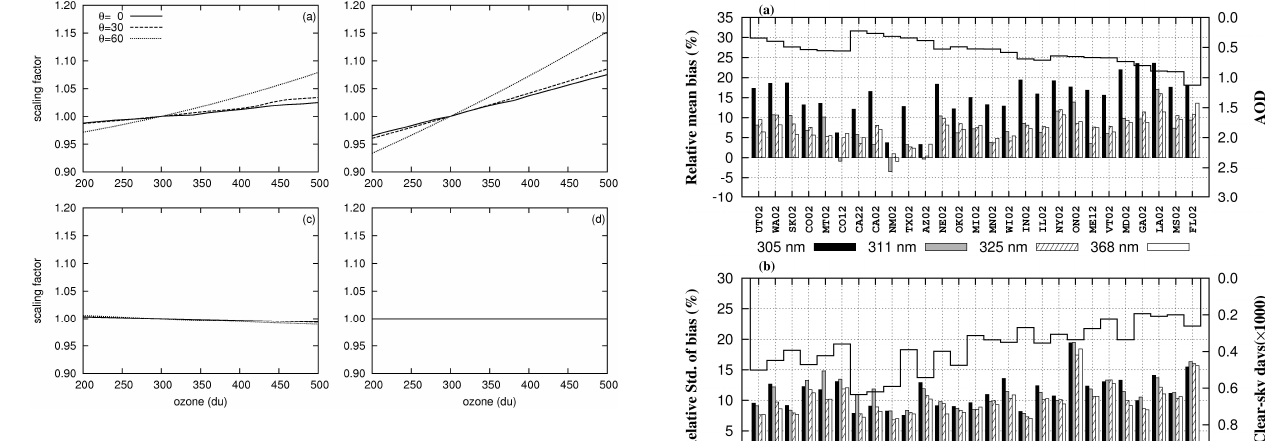
Fig. 1. Scaling factors for the re-convolution of the TOMS spectral irradiances at (a) 305nm, (b) 310nm, (c) 324nm, and (d) 380nm to the UVMRP measurements at in Bondville, IL (IL02) in July, 2003 in terms of the total column ozone for the range of 200–500DU and three solar zenith angles (0, 30, 60 degrees). The scaling factors were normalized by the corresponding values of 300DU ozone.